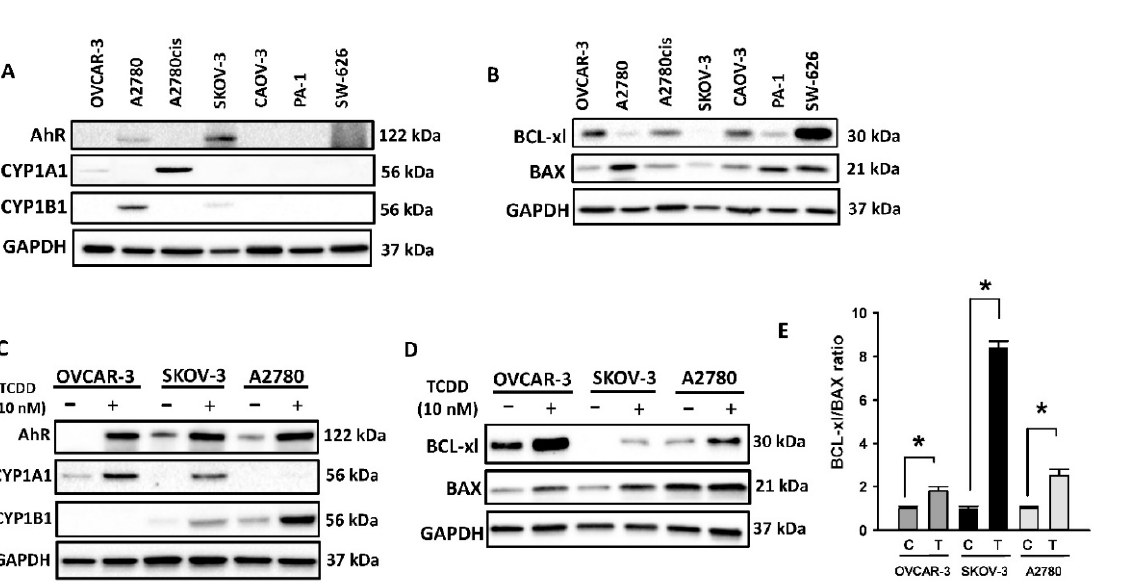
Figure 1. Constitutive and inducible expression of AhR and BCL family proteins in OC cells. Immunoblot analysis of ( A , B ) constitutive and ( C , D ) TCDD-inducible protein expression levels of the target genes in OC cells using GAPDH as a housekeeping gene. The protein panels are a composite of different blots and are representative blots for the indicated proteins and the loading control. ( E ) Fold change of Bcl-xl to BAX ratio in constitutive and TCDD-inducible OC. Intensities of each bad were quantified using ImageJ software mean ±SD ( n = 3). *; p < 0.05 compared to the corresponding control.